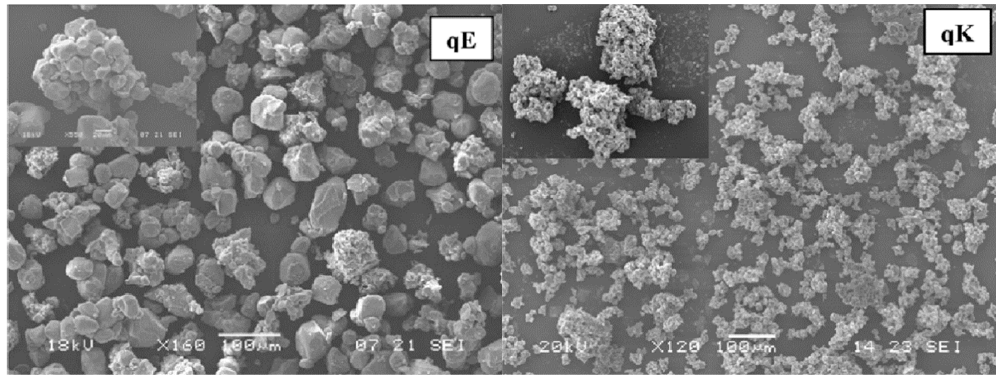
Figure 8. Scanning electron microscopy (SEM) images of Li 4 SiO 4 samples obtained from different doping methods: eutectic doping (qE); simple mechanical addition (qK) [39].